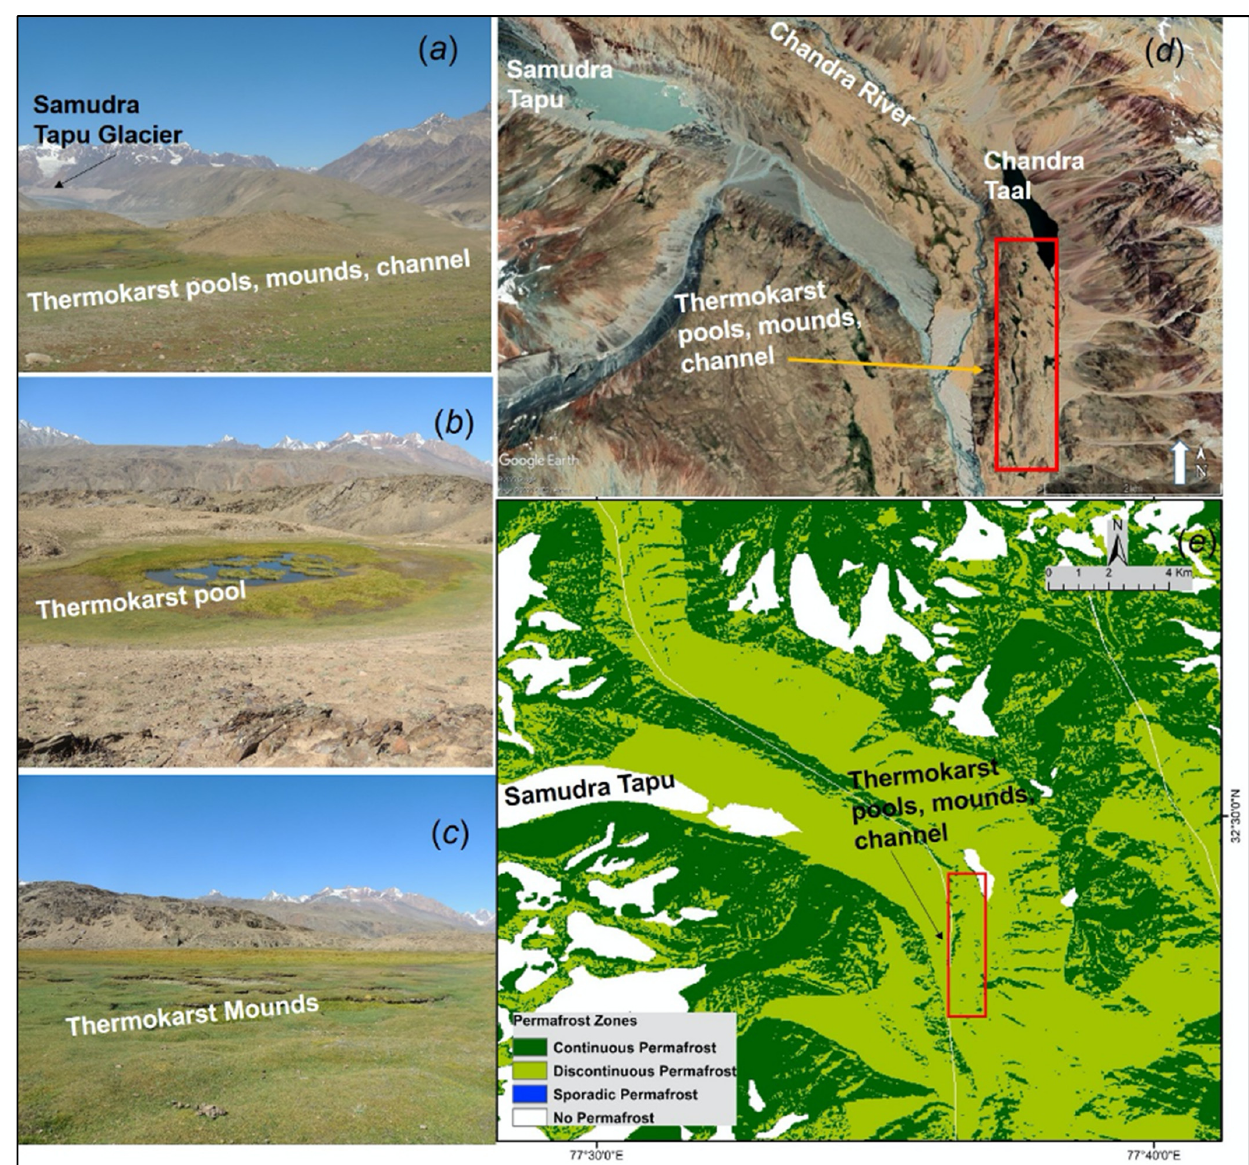
Figure 7. The field-photographs of geomorphological proxies associated with presence of permafrost ( a ) Thermokarts features close to Samudra Tapu glacier, ( b ) Thermokarts pool, ( c ) Thermokarts mounds, ( d ) GoogleEarth image of the area, and ( e ) permafrost zone classification in the area.